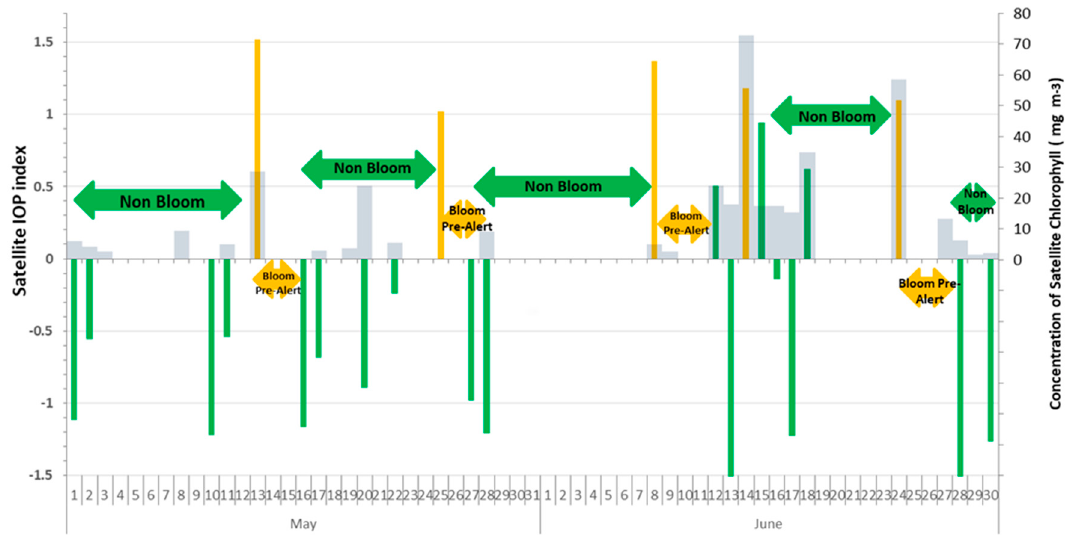
Figure 2. Temporal evolution of the satellite IOP index and satellite chlorophyll a (mg m − 3 ) from 1 May to 30 June 2017 at field point 4. Green color bars show IOP index in non-bloom conditions; yellow color bars show IOP index in bloom pre-alert conditions, gray bars are chlorophyll a . Absence of bars is due to cloud cover.